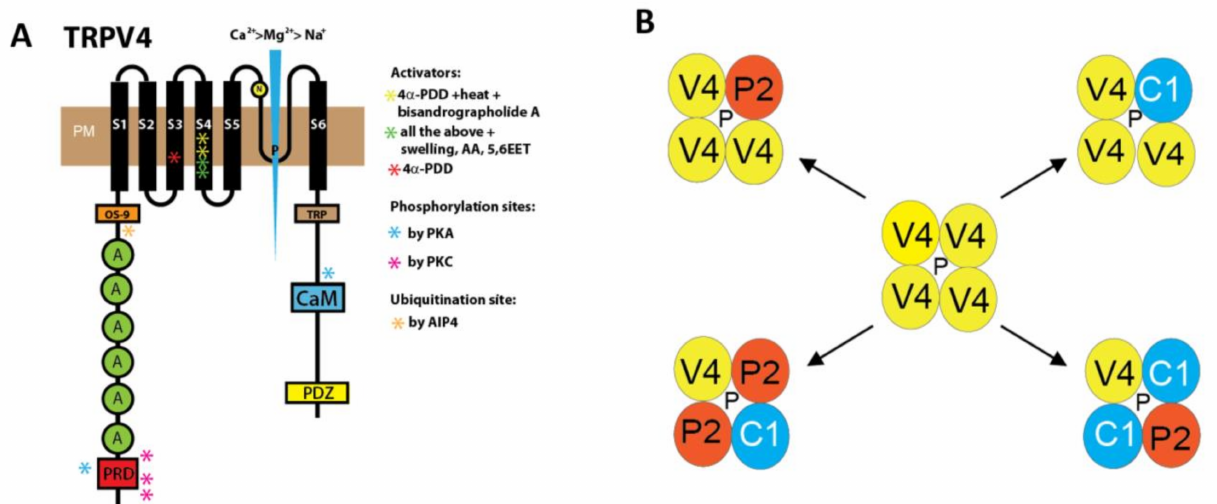
Figure 1. ( A ) Cartoon representing the structure of a he fourth member of the vanilloid family of transient receptor potential channels (TRPV4) channel with functional domains, as well as activator interaction sites (modified from Reference [31]). See text for details. 4 α -PDD, 4 α -phorbol 12,13 didecanoate; 5,6 EET, 5,6 epoxyeicosatrienoic acids; A, ankyrin repeat domain (ARD); AA, arachidonic acid; CaM, Ca 2+ /calmodulin binding site; N, N-glycosylation site; P, channel pore; PKA, protein kinase A; PKC, protein kinase C; PM, plasma membrane; PDZ, PDZ binding domain; PRD, proline-rich domain; TRP, TRP-box; S1-6, transmembrane segments 1–6. ( B ) A selection of the proposed multimerization potential of TRPV4 (V4) proteins to form functional homo- or together with Transient Receptor Potential Classical 1 (TRPC1) (C1) and Transient Receptor Potential Polycystin 2 (TRPP2) (P2) monomers hetero-tetrameric channels (modified from Reference [32]). P, channel